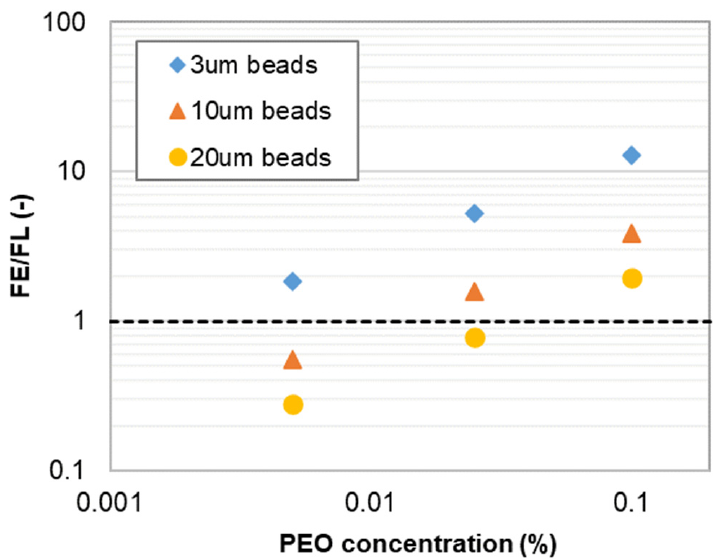
Figure 7. The ratio of F E /F L under different PEO concentrations at 0.2 mL/min.